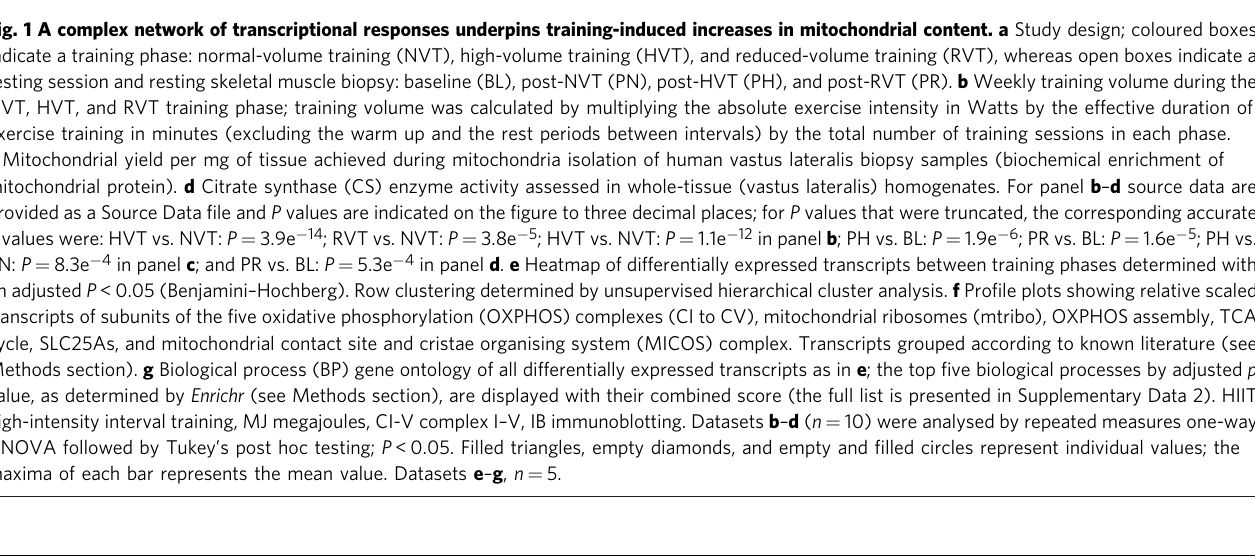
Fig. 1 A complex network of transcriptional responses underpins training-induced increases in mitochondrial content. a Study design; coloured boxes indicate a training phase: normal-volume training (NVT), high-volume training (HVT), and reduced-volume training (RVT), whereas open boxes indicate a testing session and resting skeletal muscle biopsy: baseline (BL), post-NVT (PN), post-HVT (PH), and post-RVT (PR). b Weekly training volume during the